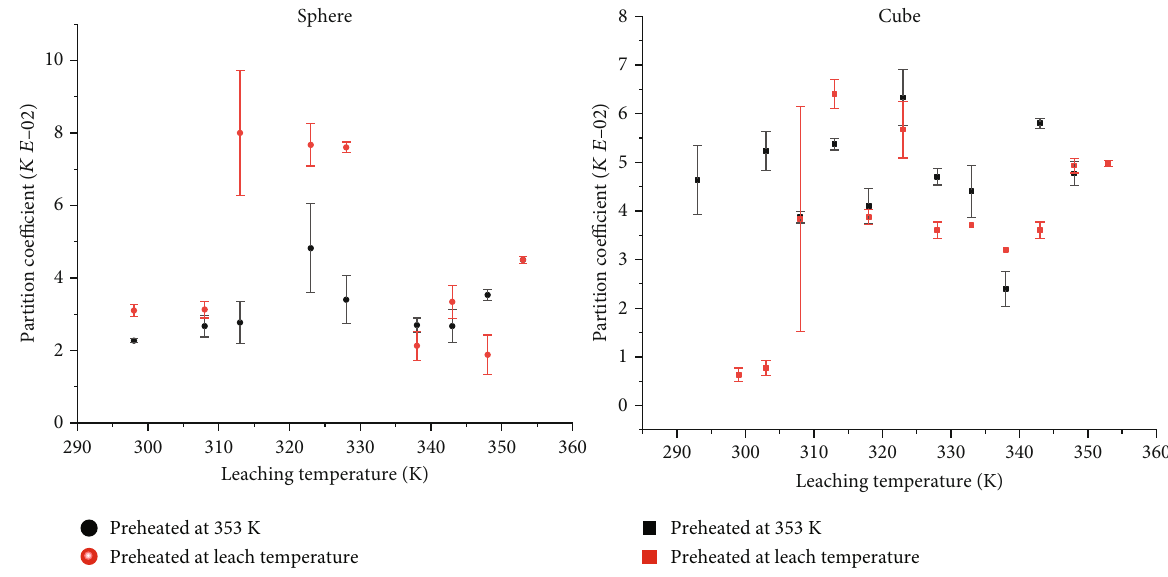
Figure 6: E ff ect of temperature on partition coe ffi cient of potassium in preheated